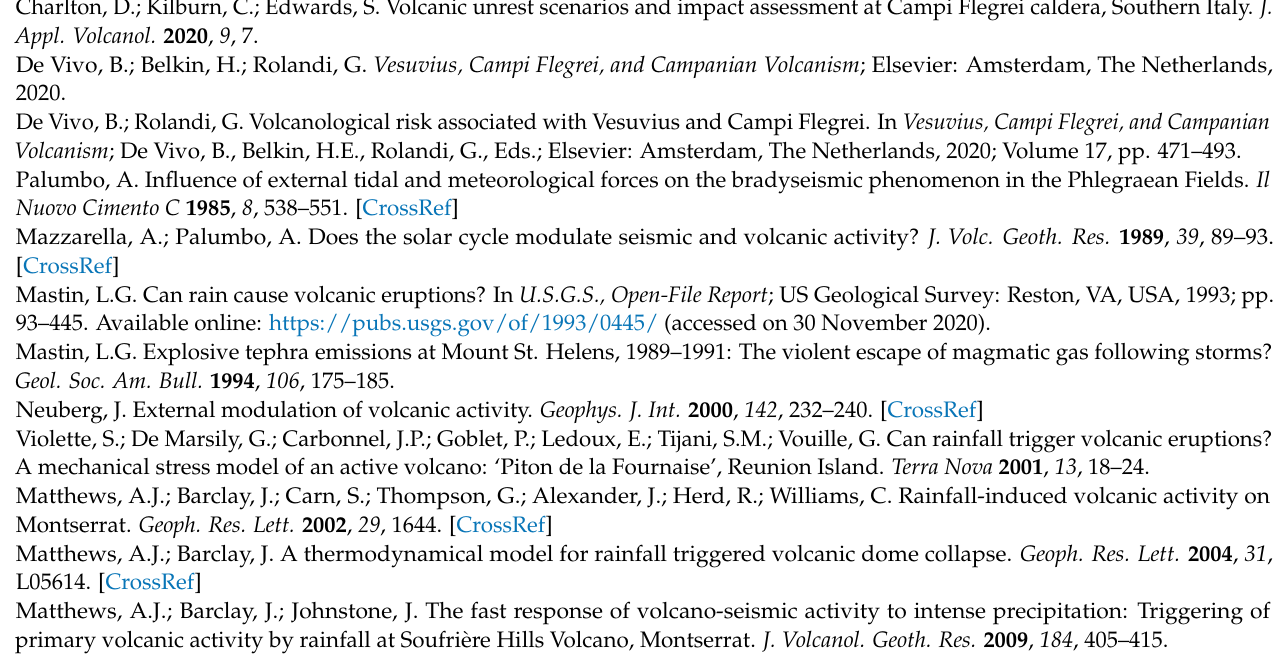
Figure A2. Rainfall time series measured at the Meteorological Observatory of San Marcellino in Naples (blue line) and the Solfatara (red line). The insert represents the calibration of Solfatara on San Marcellino.